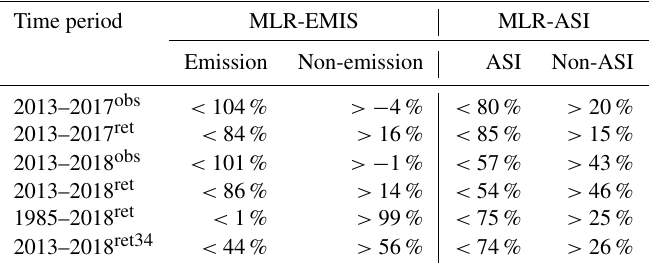
Table 6. Contributions of emissions and ASI to the PM 2 . 5 trends in